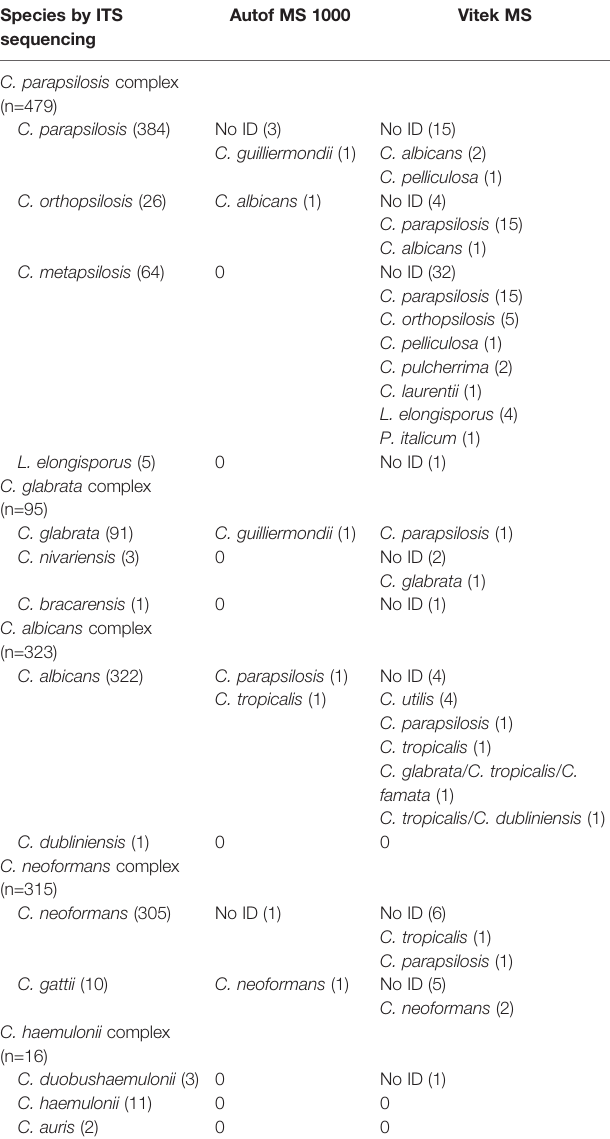
TABLE 2 | Misidenti fi cation and “ no identi fi cation ” results by two systems. Species by ITS